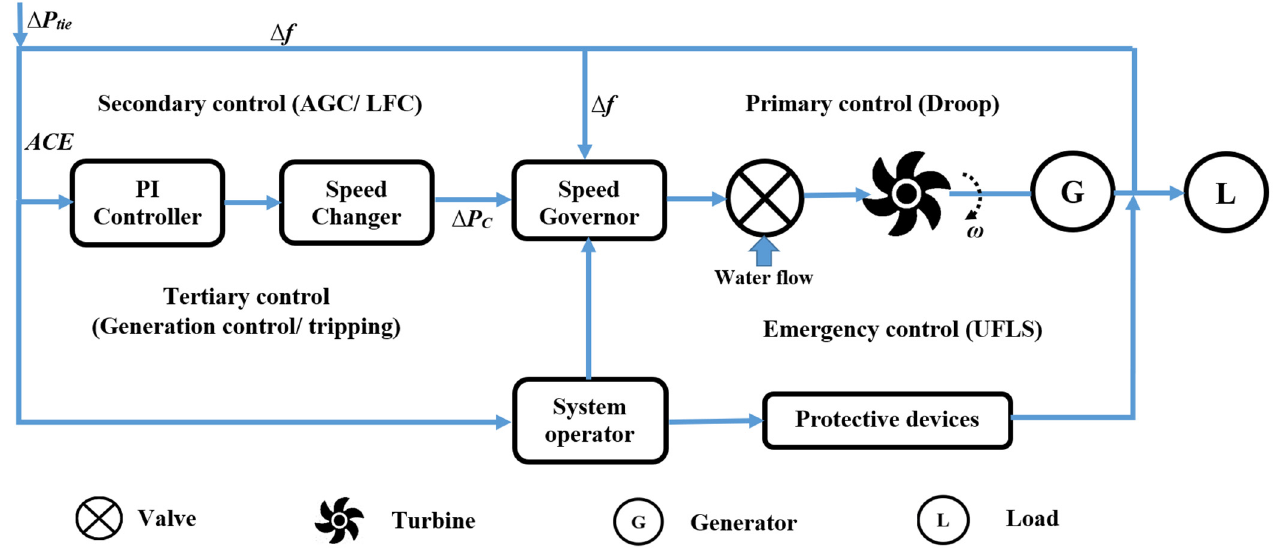
Figure 5. Frequency control techniques/loops in a power system.